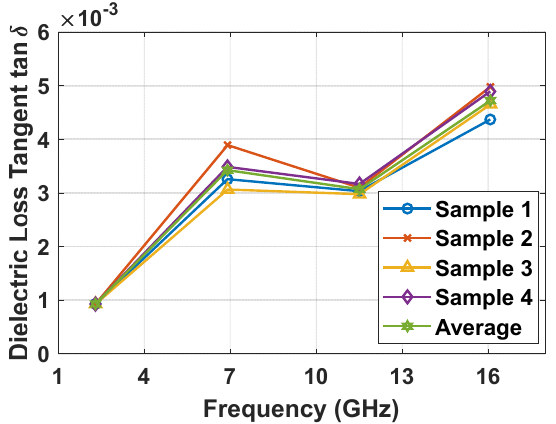
Figure 7. The extracted dielectric loss tangent values of the Taconic TLY samples. Table 2. Comparison among different resonator ‐ based methods for dielectric characterization. Work Tech.